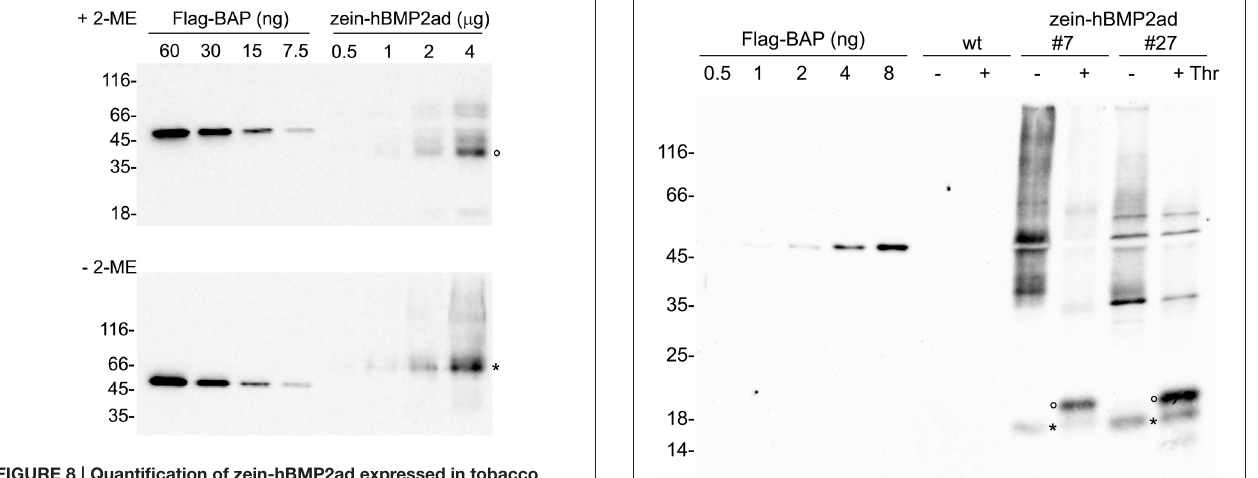
FIGURE 8 | Quantification of zein-hBMP2ad expressed in tobacco plants. Sequential dilutions of total leaf proteins (from 0.5 to 4 µ g) from zein-hBMP2ad line #23 extracted in the presence ( + 2-ME) or in the absence ( − 2-ME) of 2-mercaptoethanol were analyzed by protein blot in comparison with known amounts of the commercial standard protein Flag–BAP (lanes on the left). Empty circle: zein-hBMP2ad monomers; asterisk: zein-hBMP2ad dimers. Numbers at left indicate the position of molecular mass markers, in kD.